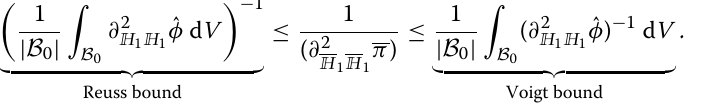
Influence of the size of the RVE on the macroscopic moduli Next, we study the effect of the size of the RVE on the resulting macroscopic moduli. The influence of the size of the RVE for M mat = 10 − 1 mm 4 /(Ns) and M incl = 10 − 4 mm 4